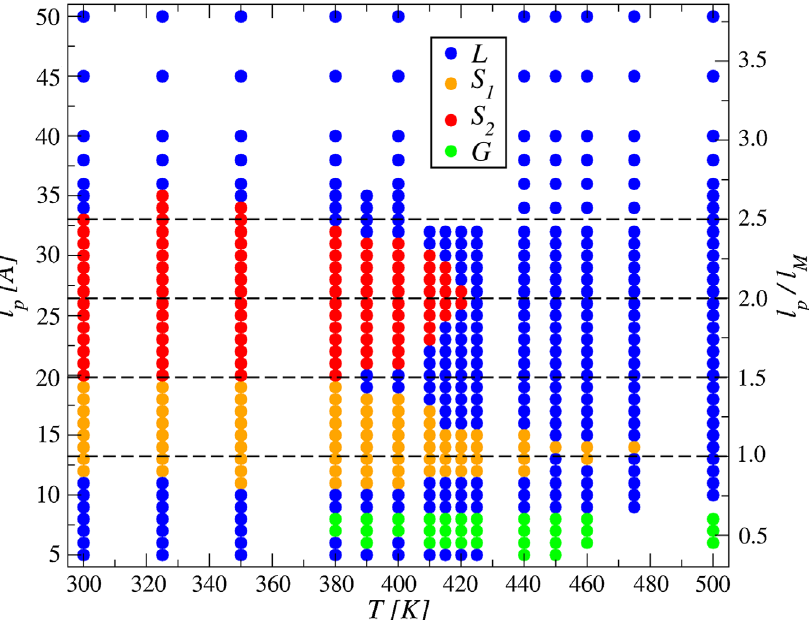
FIG. 6. Phase behavior of the confined IL. The ð T − l phase diagram, on the basis of the discussed structural and dynamical p Þ =l properties. We also show the data in terms of l (right axis). This is the most important result of the present work, demonstrating the p M possibility of capillary freezing of an ionic liquid in a nanopore, the existence of multiple arrested states, and the occurrence of a reentrant phase behavior with the stabilization of liquidlike pockets in situations of severe confinement. An interesting gel-like phase is also found, in conditions of very low density and high temperature, for confinement widths less than the rodlike cation molecular